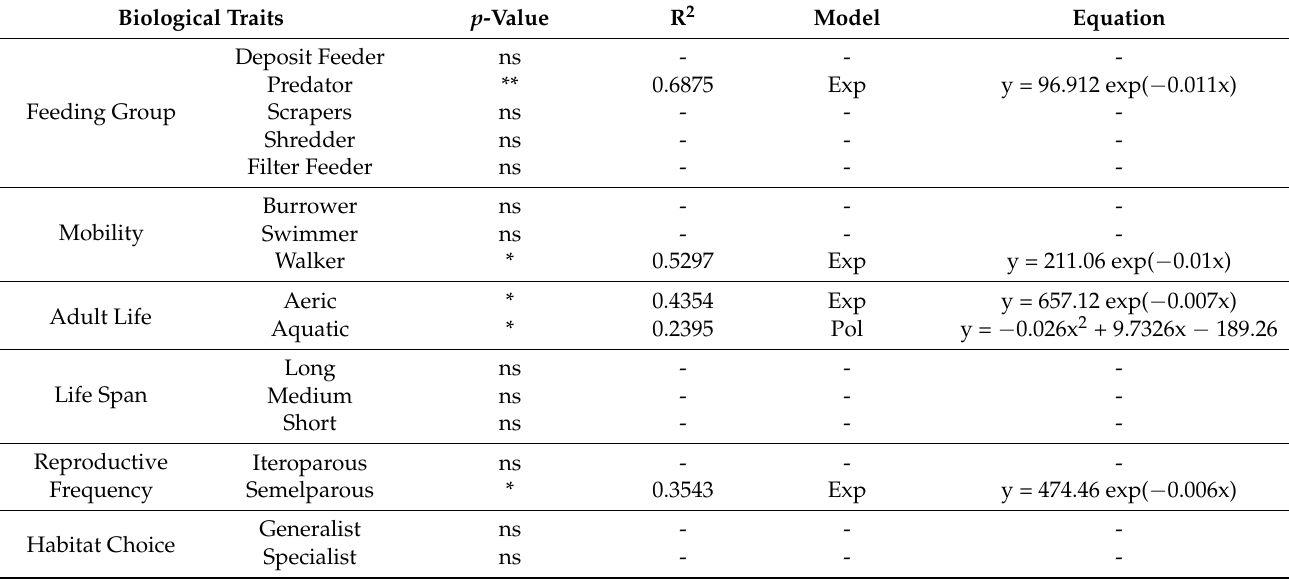
Table 5. Most fitted regression models between distance from the source and biological traits.